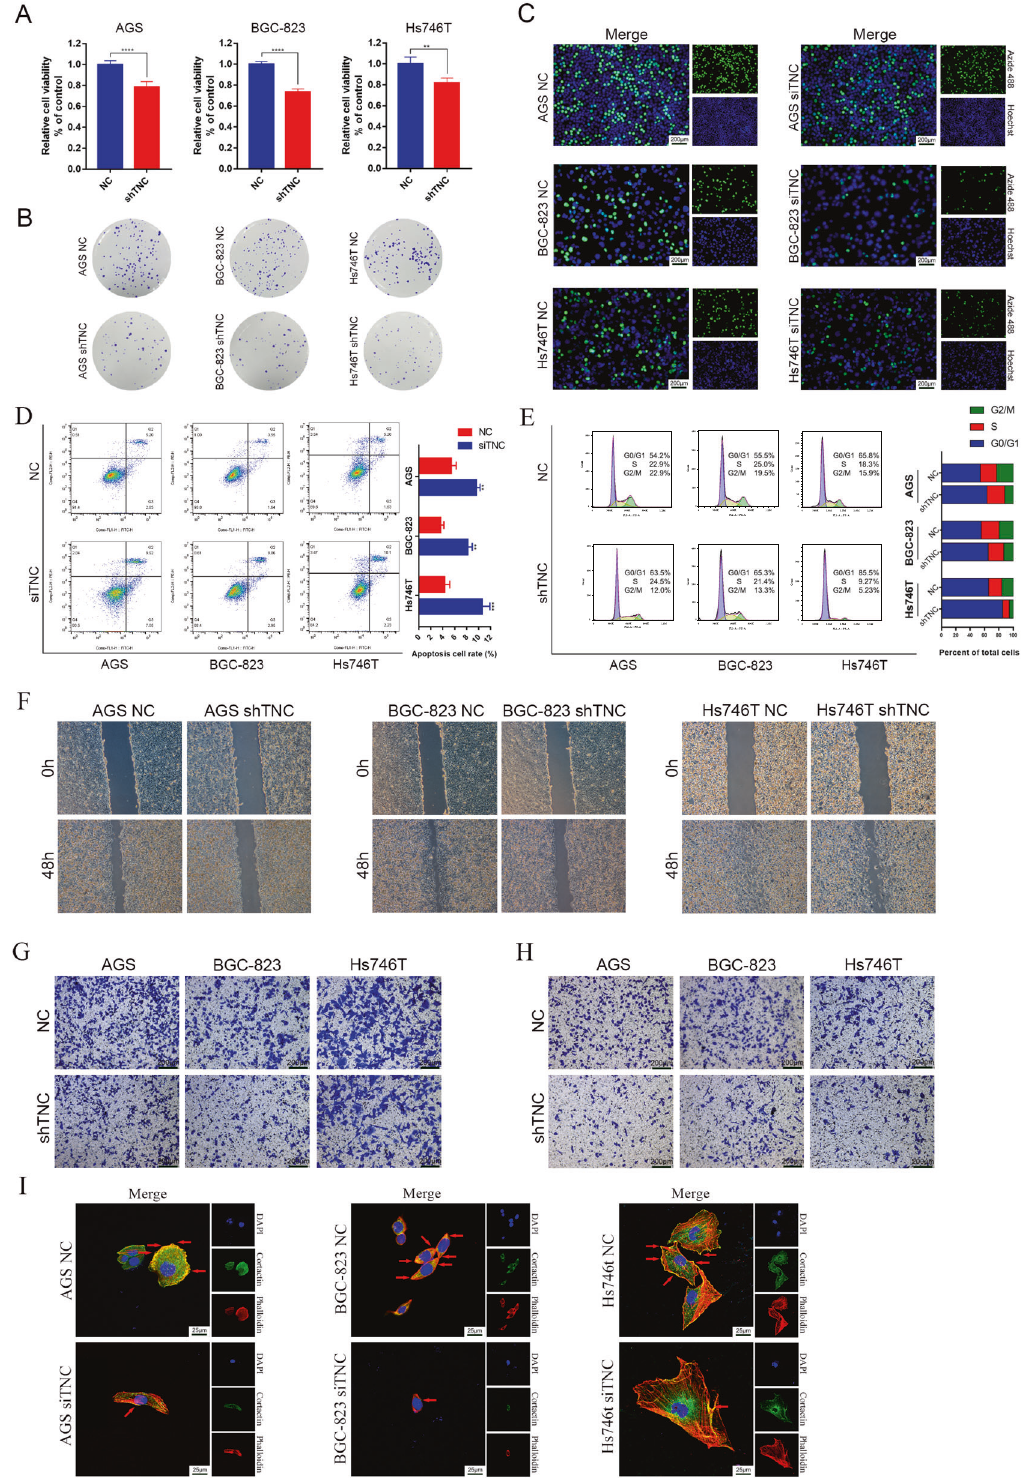
Fig. 3 TNC knockdown inhibited the proliferation, migration and invasion of gastric cancer cells. CCK-8 ( A ), colony formation assay ( B ) and EdU assay ( C ) showed that TNC knockdown inhibited the proliferation of gastric cancer cells; fl ow cytometry showed that TNC induced cell cycle arrest ( D ) and apoptosis ( E ) in gastric cancer cells; cell migration was detected by wound-healing assay ( F ) and transwell assay ( G ); cell invasion was detected by transwell assay ( H ) and pseudopodia formation assay ( I ). Results were shown as mean ± SD of three independent experiments; each experiment was performed in triplicate. ** P < 0.01; **** P < 0.0001.